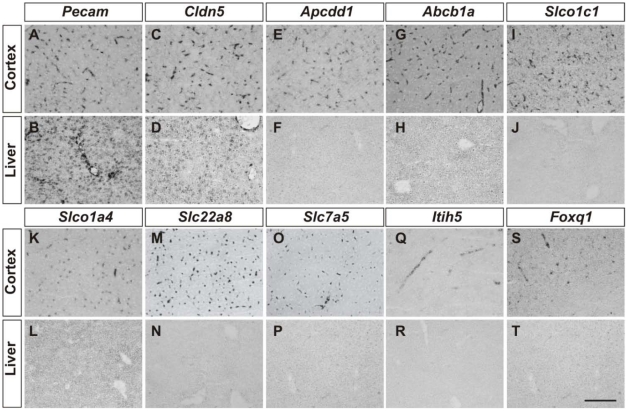
Selective expression of blood-brain barrier-enriched genes in CNS endothelial cells.Expression of Pecam (A, B), Cldn5 (C, D), Apcdd1 (E, F), Abcb1a1 (G, H), Slco1c1 (I, J), Slco1a4 (K, L), Slc22a8 (M, N), Slc7a5 (O, P), Itih5 (Q, R) and Foxq1 (S, T) mRNA in the brain and liver of P20 mouse pups. The top four brain endothelial transcripts enriched compared with liver (Itih5, Apcdd1, Abcb1a and Slco1c1) and lung endothelial cells (Slc22a8, Slc7a5, Slco1a4 and Foxq1) were analyzed, excluding transcripts also expressed in the brain parenchyma (brain GFP+:brain GFP−<2), and those expressed at <10000 to ensure that the signal would be above the detection limit of the in situ hybridization. Note that Pecam1 and Cldn5 mRNAs are expressed in the endothelial cells in both brain and liver. However, the transcripts for the blood-brain barrier enriched genes are only present in brain but not liver endothelial cells. Bar, 200 microns.